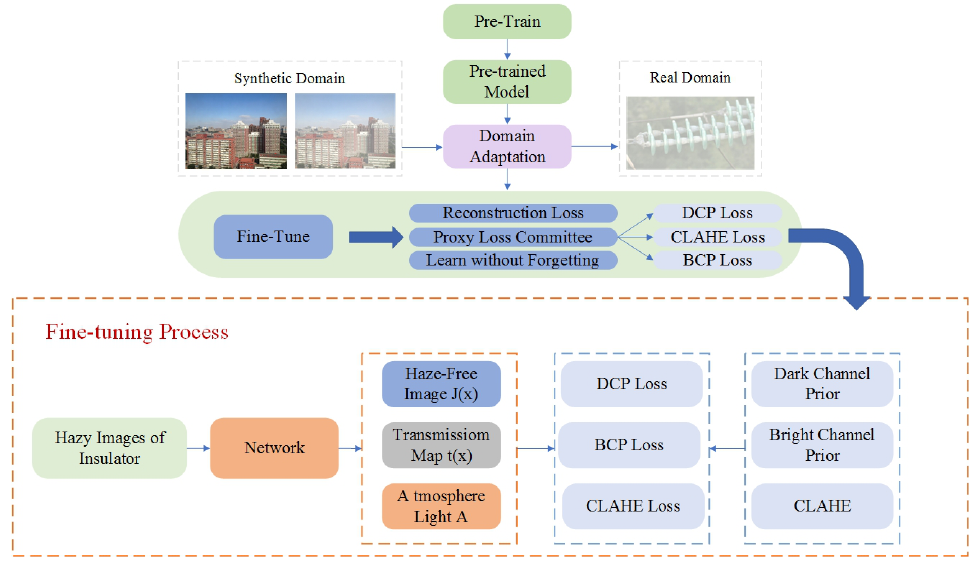
Figure 4. Structure of the dehaze